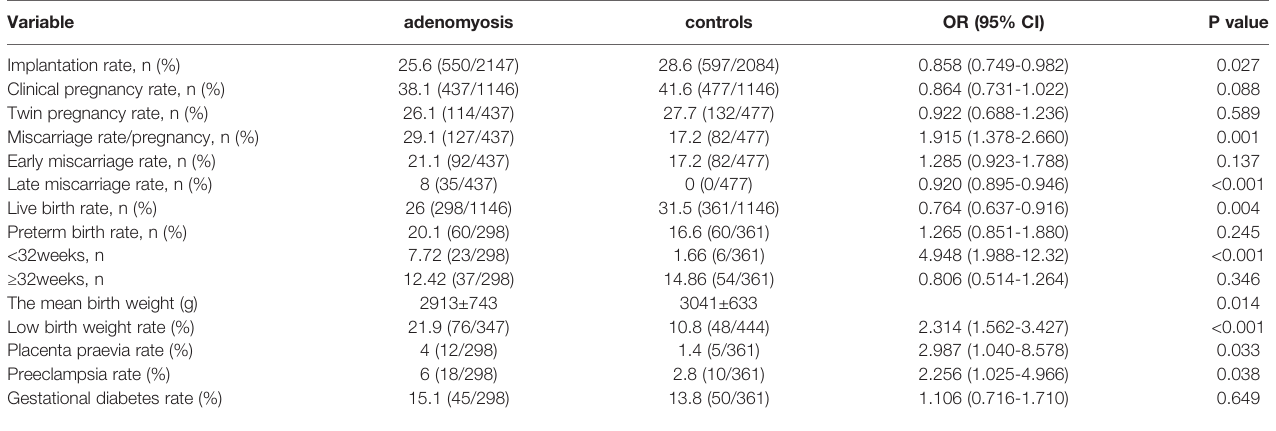
TABLE 3 | Reproductive outcomes calculated per fresh ET cycle. Variable